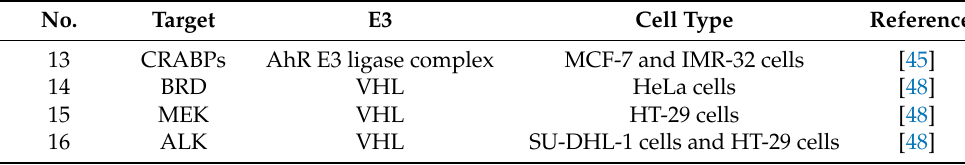
Table 6. Natural product targets 13–16.